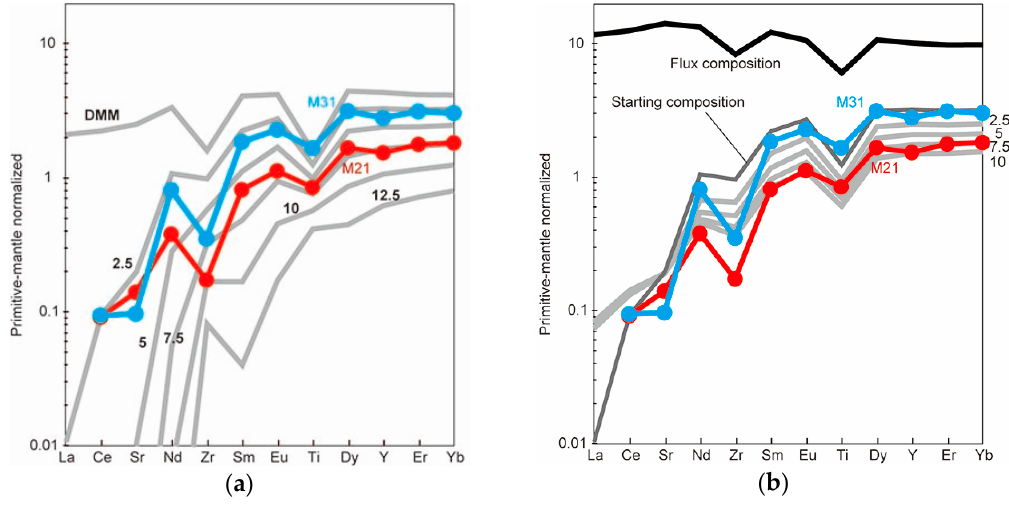
Figure 11. Averaged and modeled primitive-mantle-normalized trace element patterns for clinopyroxenes. Details of how the data were obtained are outlined in the text. ( a ) Modeled clinopyroxene trace element compositions after fractional melting under the spinel peridotite stability field. The 2.5, 5, 7.5, 10 and 12.5 degrees of partial melting after fractional melting are shown. ( b ) Modeled clinopyroxene compositions after influx melting under conditions of the spinel peridotite stability field. The influx composition is the accumulated melt after 2.5% fractional melting modeled in ( a ). The 2.5, 5, 7.5, and 10 degrees of partial melting after influx-induced open-system melting are also shown. Mineral/melt partition coefficients are from [31,33]. Melting models were obtained using the spreadsheet of [33].